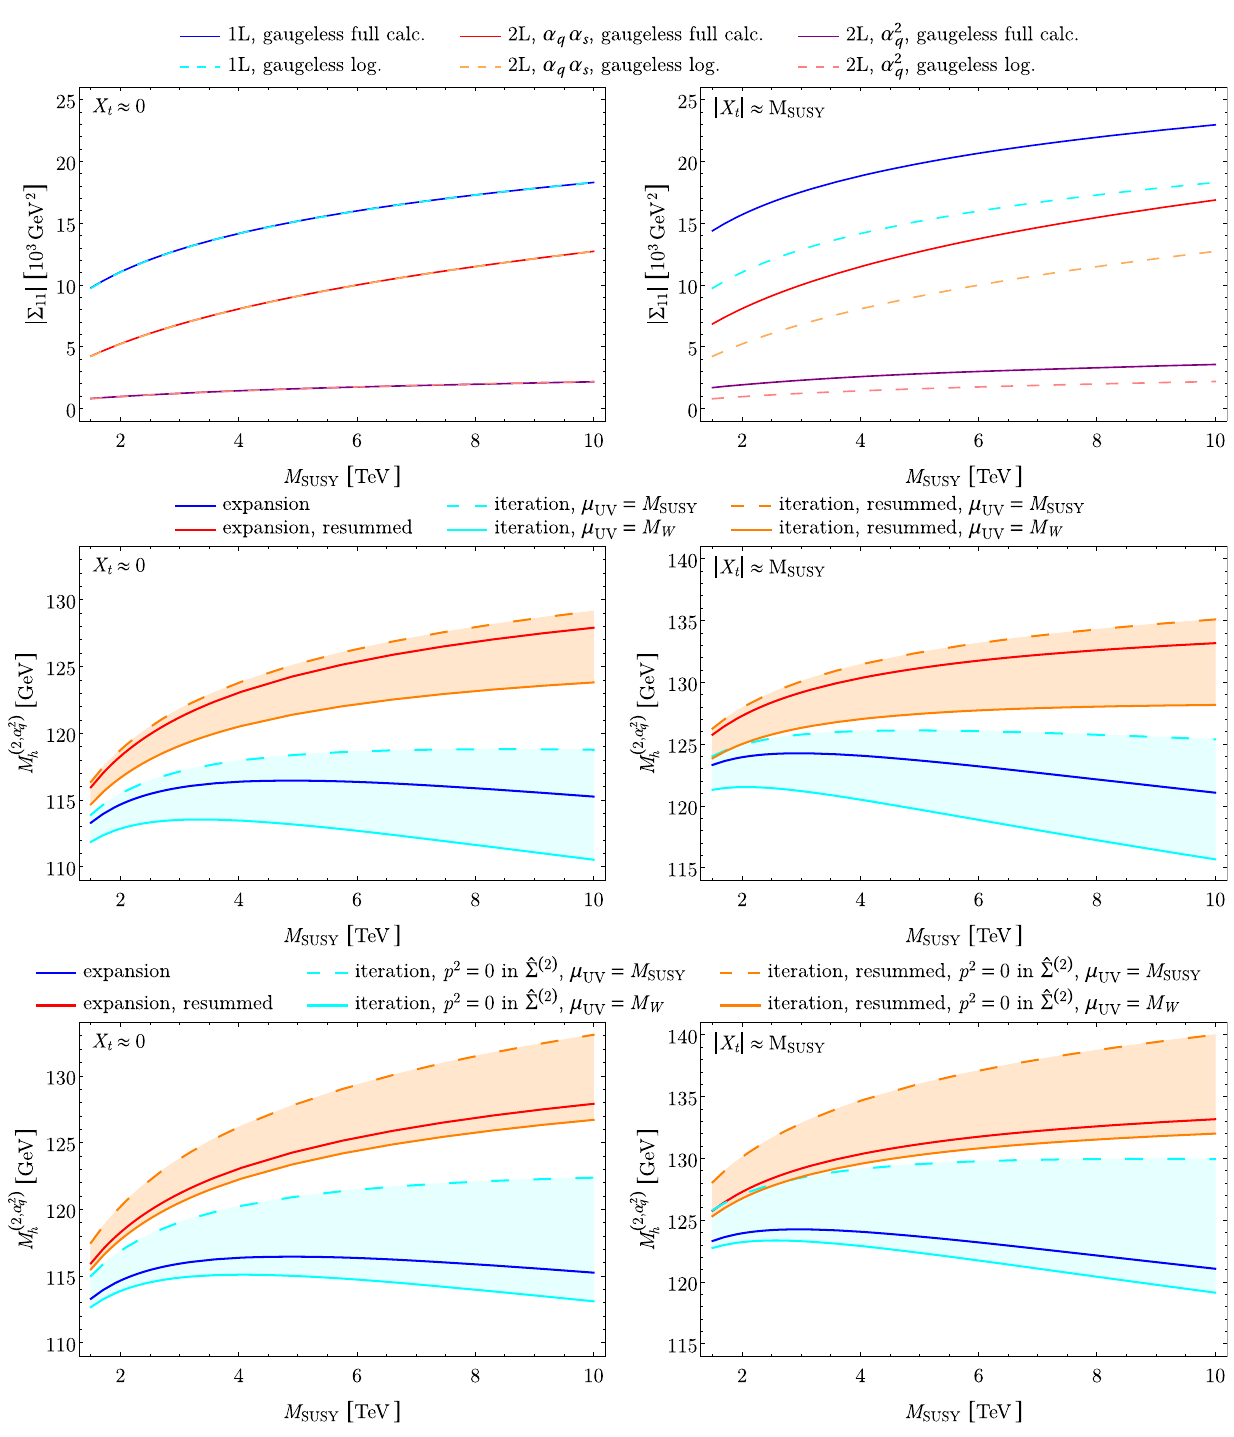
Fig. 11 Impact of the resummation of UV-logarithms of (cid:2) α , α α , α 2 ) for the Higgs-mass prediction and the field O q q s q dependence. Up: Higgs self-energies in the gaugeless limit (solid curves) compared to the logarithmic expansion (dashed curves). Middle: mass predictions with resummed UV-logarithms (red and orange) compared to the strict FO expansion (blue and cyan). Both the